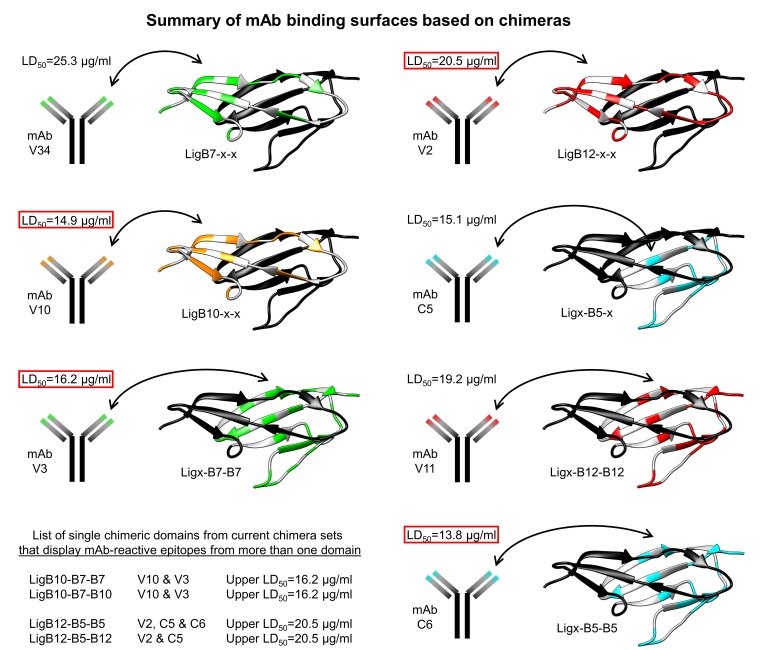
Summary of mAb binding surfaces based on chimeras.LigB Ig-like domain chimeras were used to screen which protein surfaces possessed immunoreactivity to the library of LigB mAbs. The Ig-like domain region of mAb specificity is mapped to the corresponding residue location of the LigB12 structure (PDB ID 2MOG). Colored residues (green, LigB7; orange, LigB10; red, LigB12; cyan, LigB5) indicate the location of non-identical residues within the chimera set (LigB7/B10 or LigB5/B12), while white residues indicate identical residues in the chimera parent alignments. The mAb LD50 (Table 1) is listed with the lowest value specific to the N-terminal sheet (strands A-C) and the C-terminal sheet (strands C′-G′) for each chimera set boxed in red. The upper LD50 is also listed (lower left) for chimeric domains that can be detected with dual-parent domain mAb specificity.